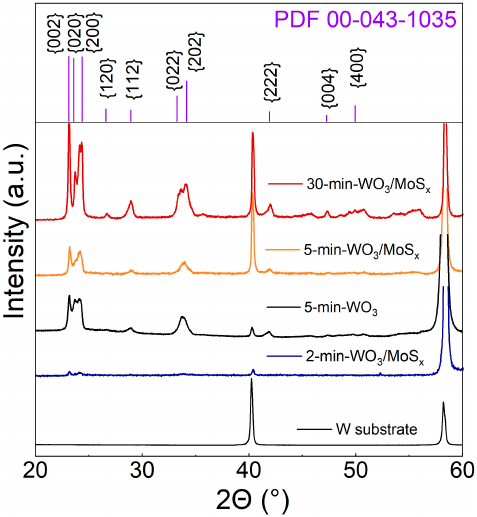
Figure 3. XRD di ff ractograms of W substrate, a WO 3 fi lm synthesized for 5 min, and heterostruc- tured fi lms, synthesized for 2, 5, and 30 min.